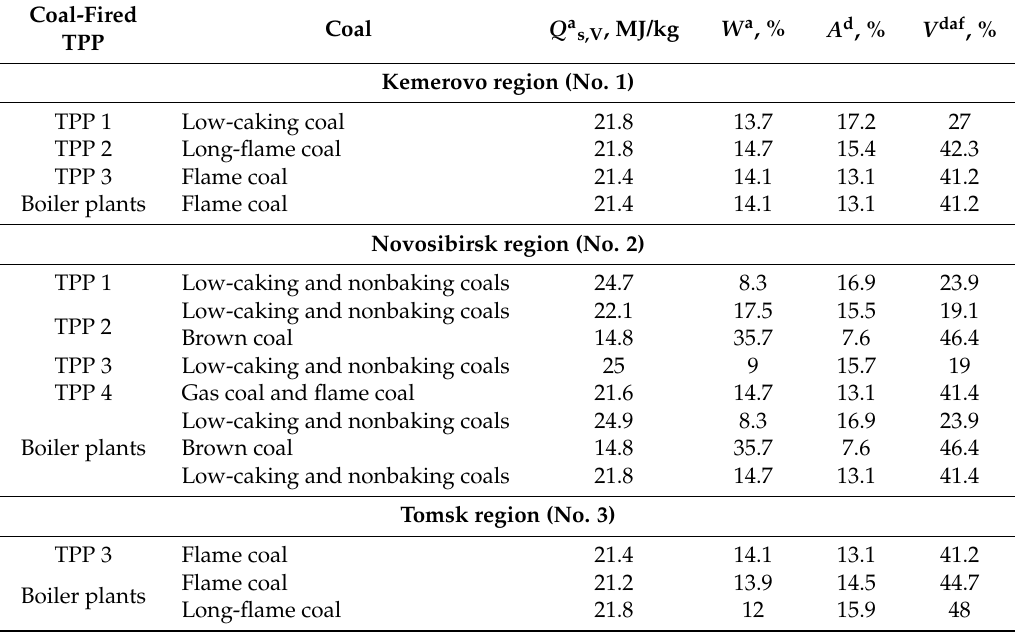
Table 9. Characteristics of coals used for power generation